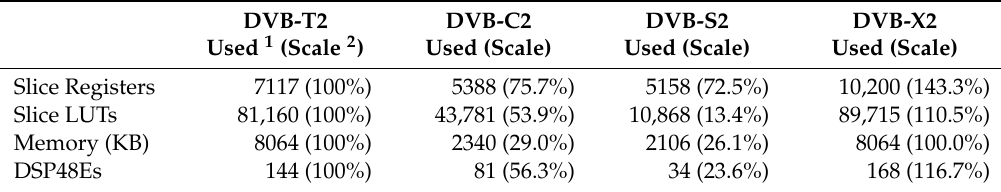
Figure 15. Test environment for the proposed DVB-X2 receiver. Table 3. Implementation results for the DVB-X2 receiver engine.